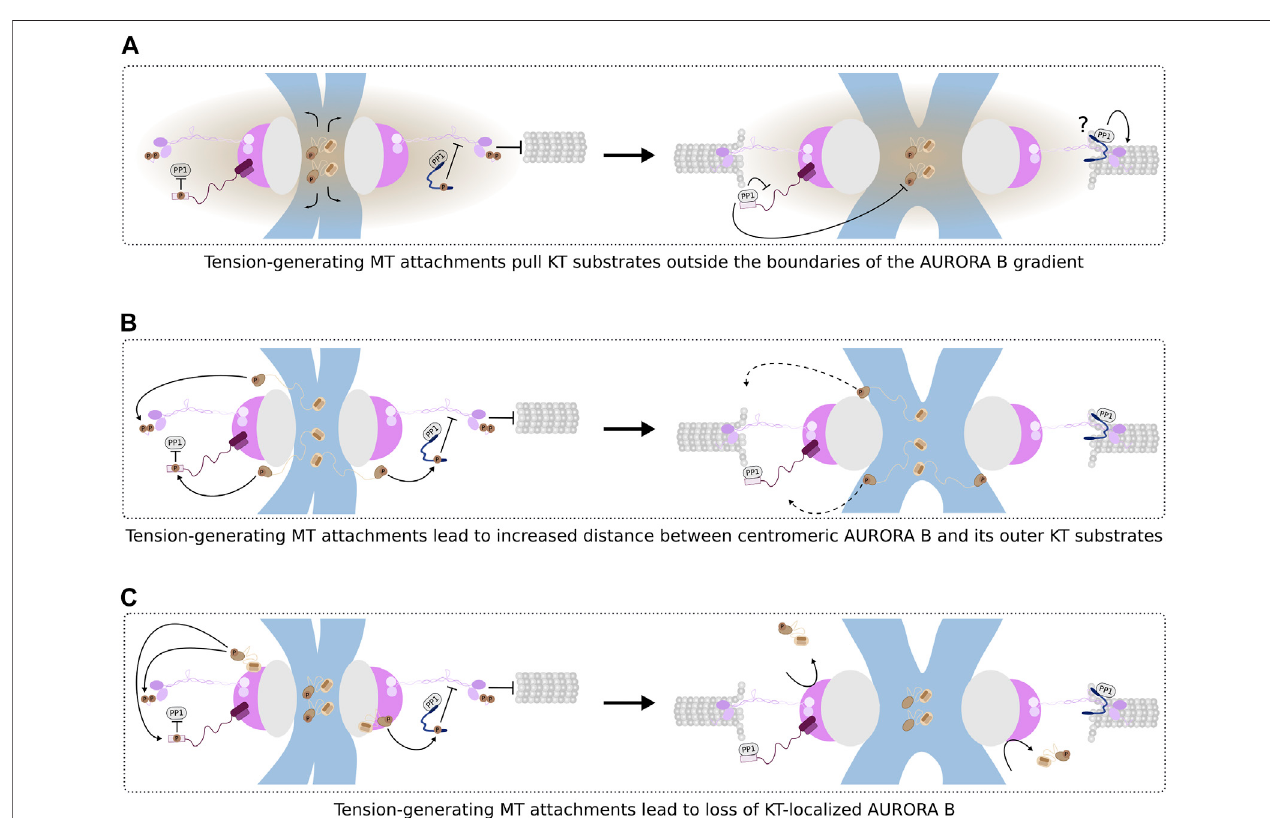
FIGURE 3 | AURORA B-dependent regulation of KT-MT attachment stability. (A), B) Spatial positioning models for AURORA B function based on a (A) diffusible phosphorylation gradient or (B) physical distance between the kinase and substrates. Both models predict that the increase in inter-KT tension as a result of correct amphitelic KT-MT attachments pulls KT substrates away from the zone of in fl uence of active AURORA B. (C) Model for the regulation of KT-localized AURORA B function. In this model, the gradual increase in KT-MT attachment stability evicts AURORA B from KTs which, in turn, further stabilizes KT-MT interactions. DephosphorylationofAURORABsubstrateslikeNDC80,KNL1andtheSKAccontributestostabilizeload-bearingend-on attachments. Interestingly,theSKAcrecruits PP1 to KTs, but it remains elusive whether such PP1 pool contributes to the stabilization of KT-MT interactions ( “ ? ” ).